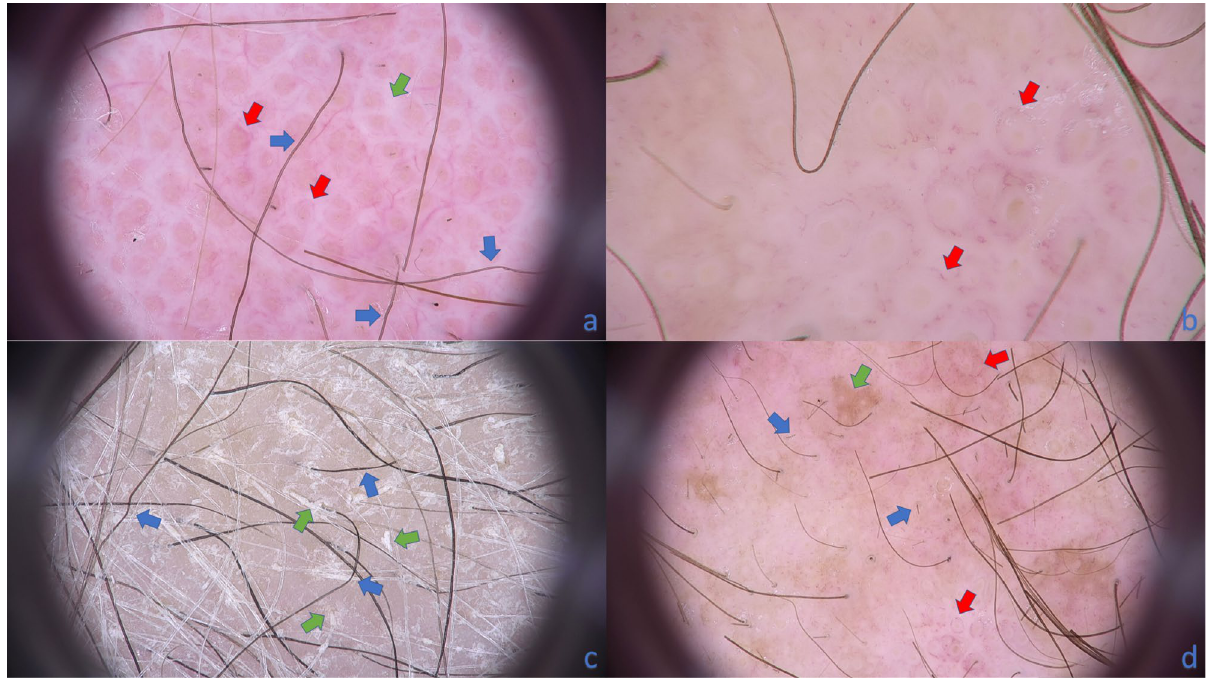
Figure 2. Trichoscopy of patient with erythrodermic CTCL. (a) The characteristic trichoscopic features visible on this image are: pili torti (blue arrows), thick white bands localized interfollicularly (green arrow) and perifollicular arrangement of linear vessels (red arrows)(× 20). (b) Vessels perifollicular arrangement can be easily recognized (red arrows). Short linear vessels are seen around yellow dots (empty follicular openings field with keratin mass and sebum)(× 70). (c) Numerous pili torti are marked with blue arrows. Additional feature seen if trichoscopy is performed without immersion fluid is follicular spicules-like scaling (green arrows)(× 20). (d) Short broken hairs are marked with blue arrows, perifollicular vessels arrangement with red arrows and patchy brownish discoloration of background with green arrow (× 20).